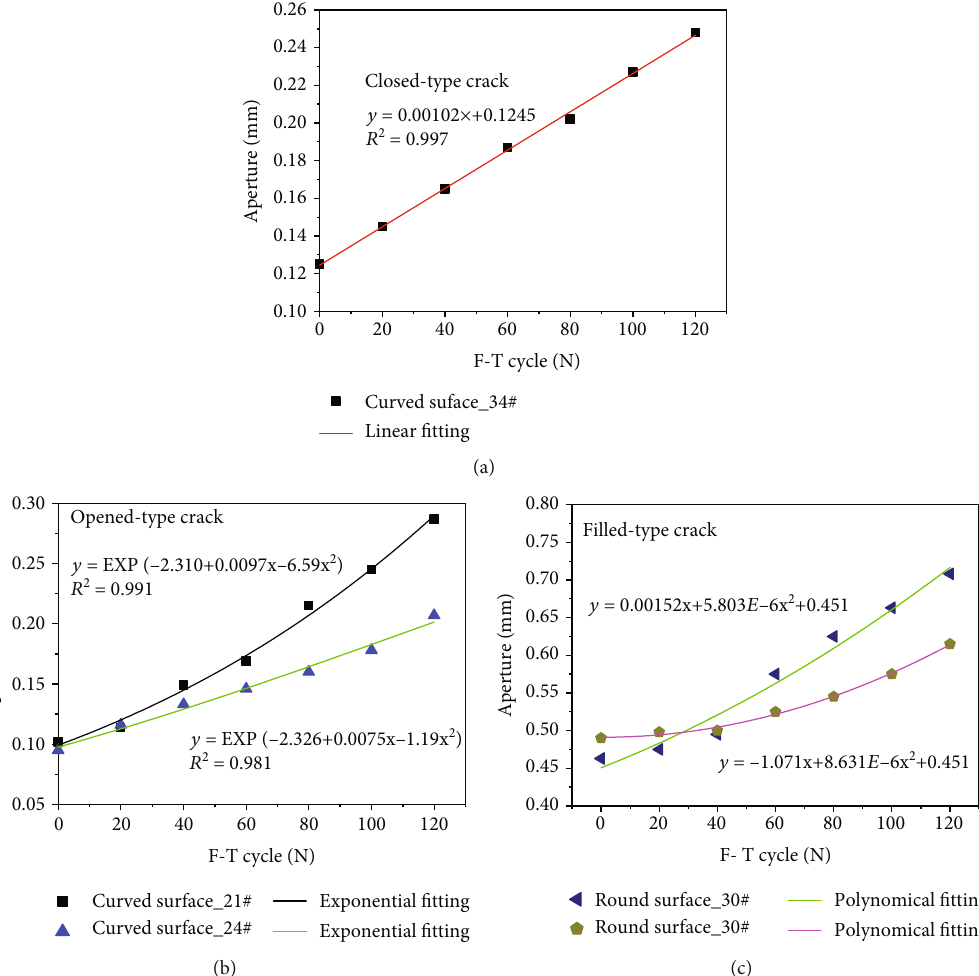
Figure 8: Depict of the changes of natural fracture aperture with F-T cycles. (a) Closed-type natural fracture; (b) opened-type natural fracture; (c) fi lled-type natural